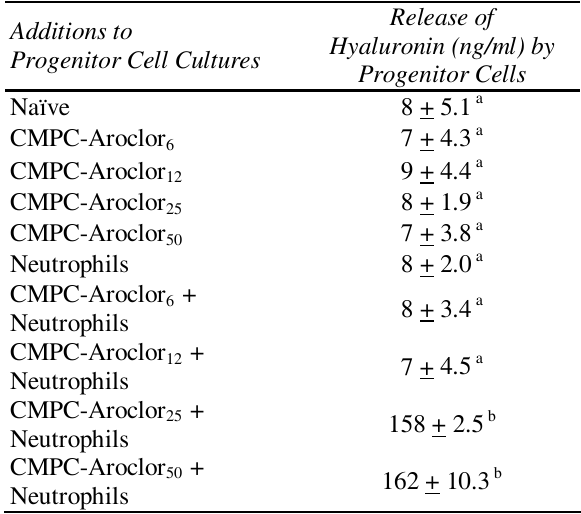
Table 7: Induction of Neutrophil-Dependant PC toxicity by Conditioned Medium from PC Treated with Aroclor. or vehicle was CMPC-Aroclor (6, 12, 25 or 50 µM) administered to neutrophil/PC co-cultures (2 X 10 6 /5 x 10 6 cells/mL, respectively) and incubated for 24 hrs. After this incubation, the content of hyaluronan in culture mediuM was analyzed as a marker of PC = conditioned mediuM from toxicity. CMPC-Aroclor (X) PC treated with Aroclor, where (X) is the concentration of Aroclor; Values represent mean + S.E.M.; a, b indicate values that are significantly different (p<0.05).